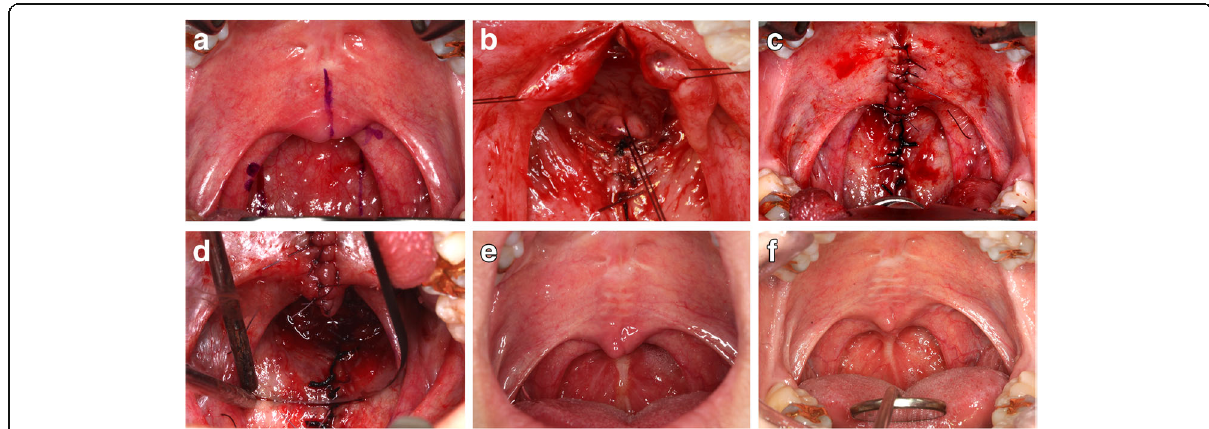
Fig. 1 Surgical procedure of superiorly based posterior pharyngeal flap and postoperative cicatrization (case 1). a – d Surgical procedure of depicting a typical posterior pharyngeal flap. e , f Postoperative photos while phonating /a/ at 3 months and 6 months post-pharyngoplasty. At